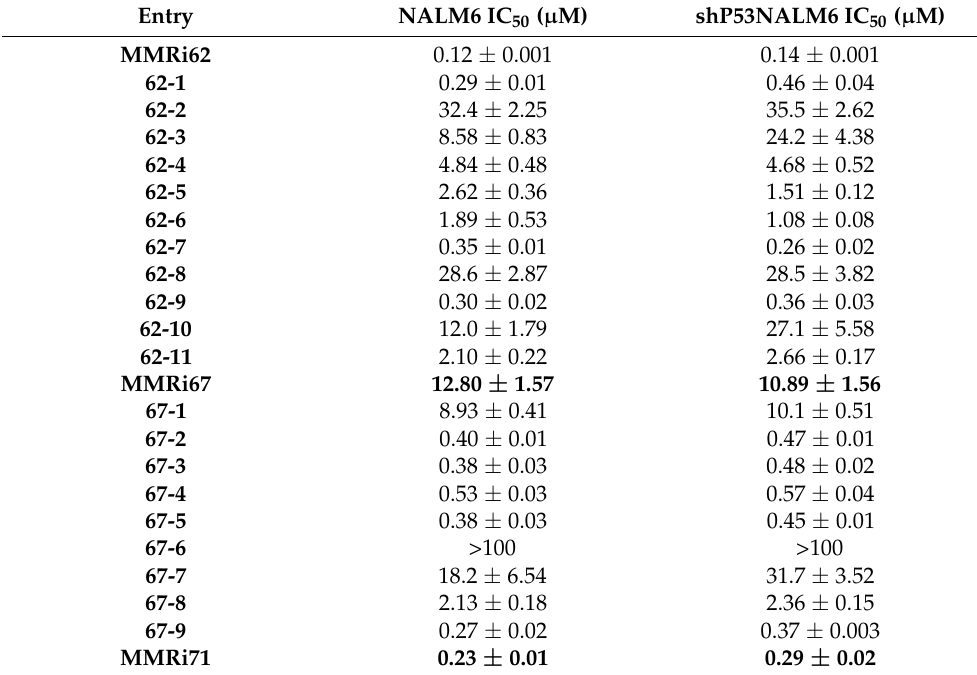
Table 1. MMRi62 and MMRi67 compound series IC 50